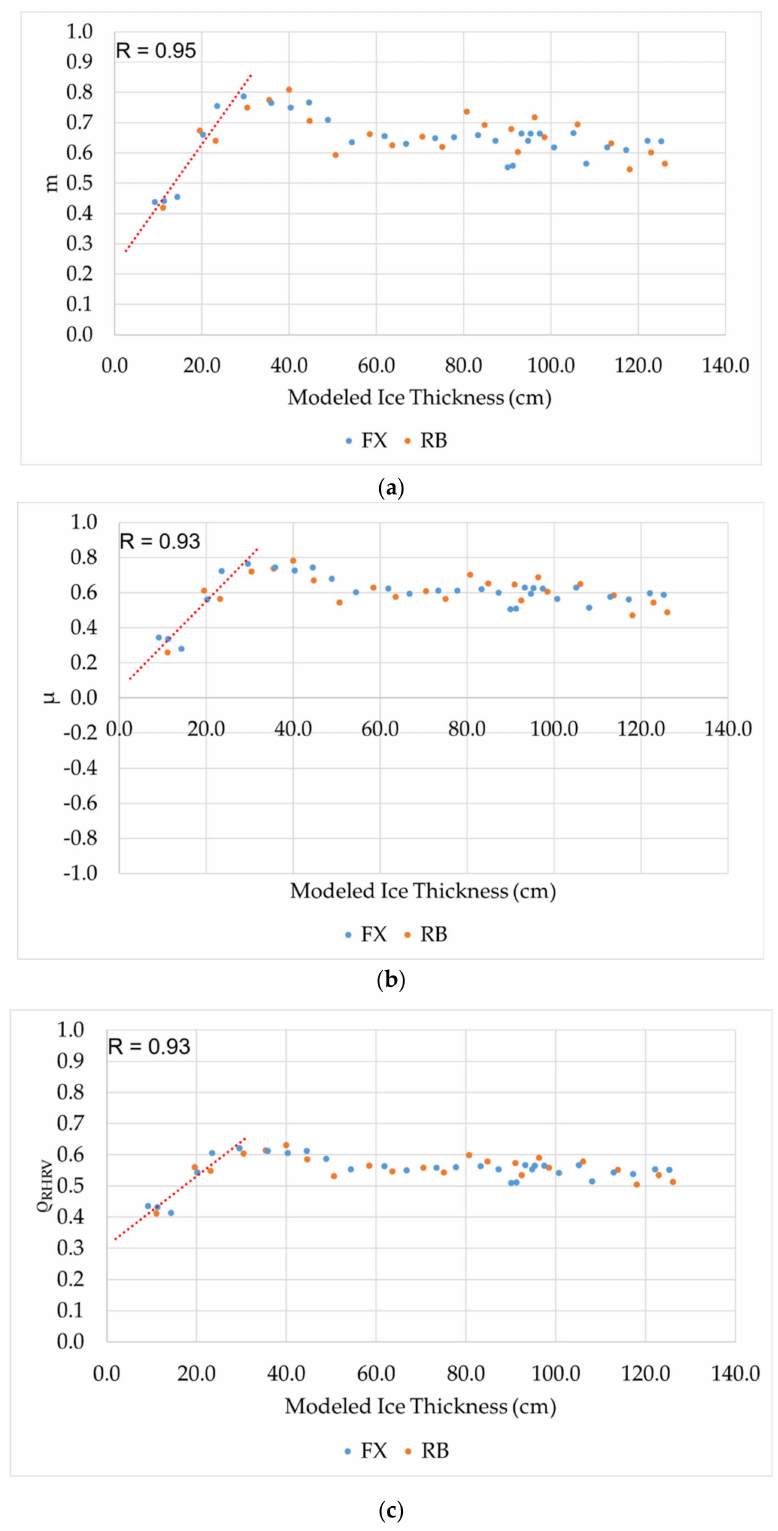
Figure 9. Temporal evolution of ( a ) m, ( b ) µ , and ( c ) ρ RHRV with ice thickness. Red trend line is included for values in the range sensitive to ice thickness. R is the correlation coe ffi cient of linearly regressed